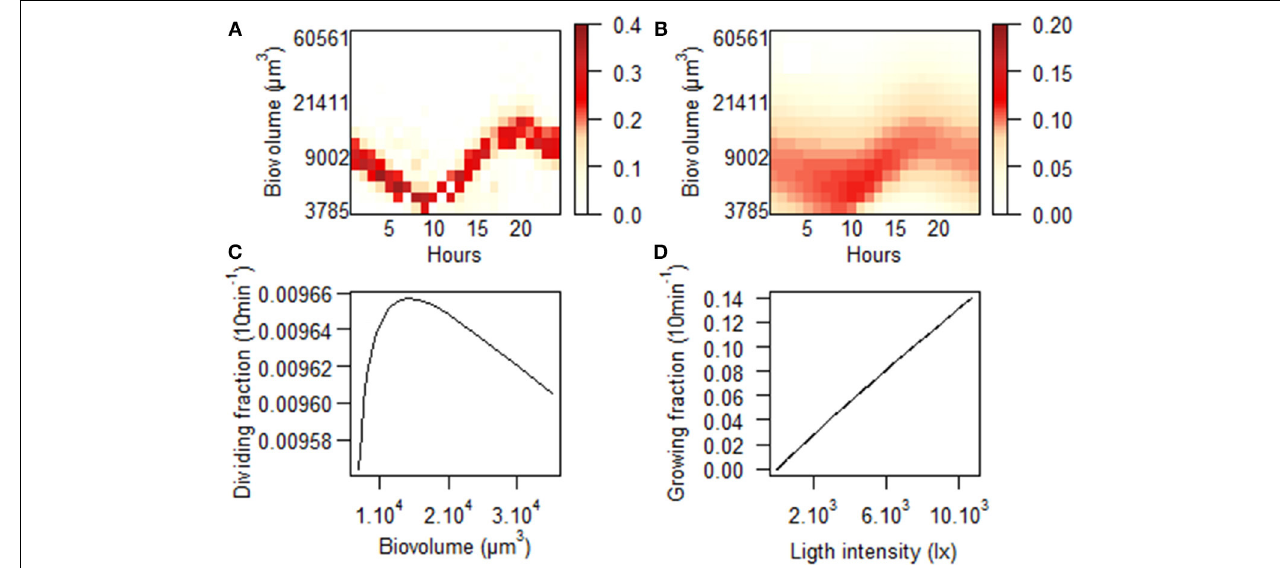
FIGURE 11 | Output of the size structured population model applied to cluster C4 on October 11th 2011: Diel variations of the (A) observed and (B) theoretical distributions of cell proportions in each size class. The